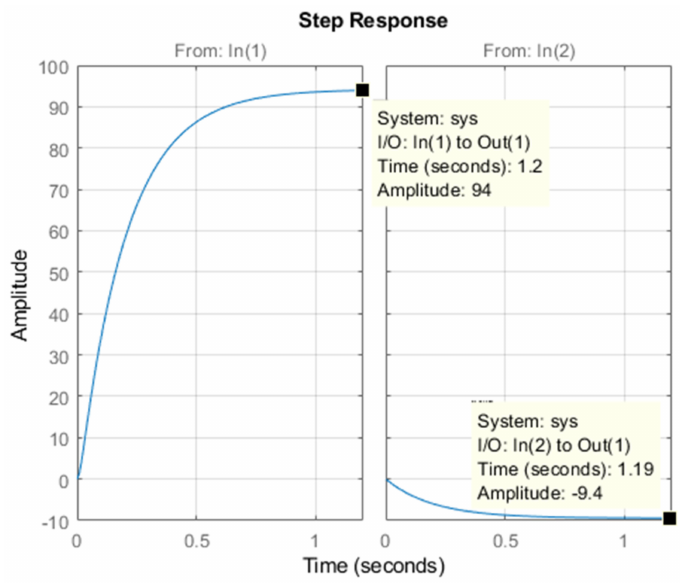
Figure 3. Open loop motor speed. Input 1 is armature voltage and input 2 is a step